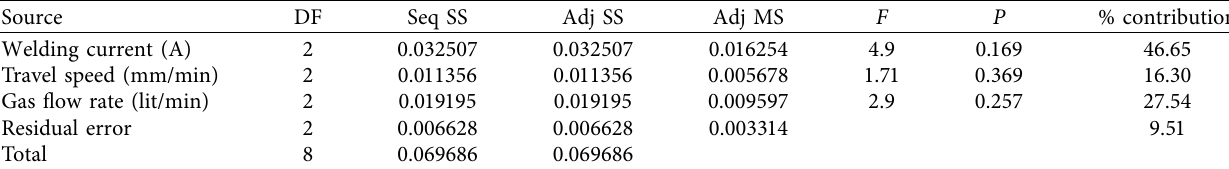
Table 4: ANOVA for GRG.